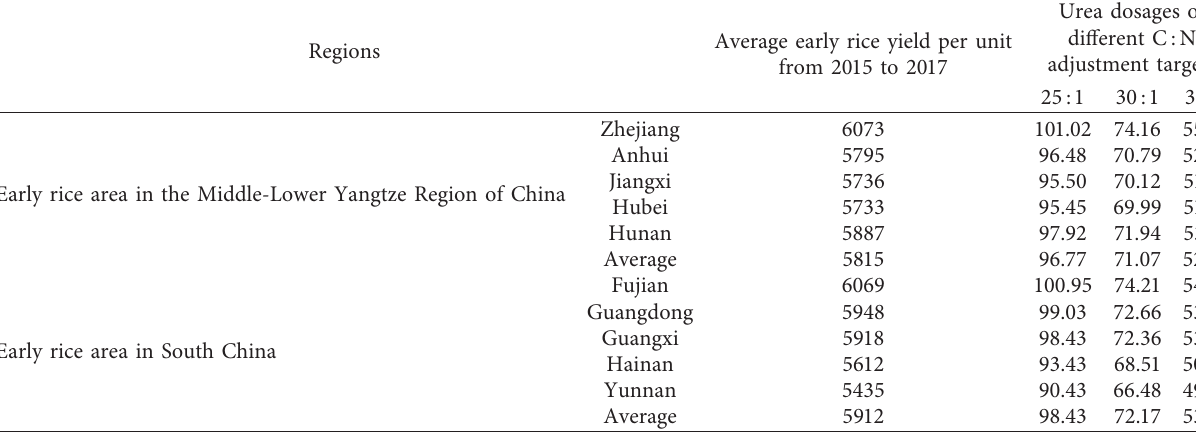
Table 7: Enquiry table for urea applied to early rice straw returning to the field in two major early rice areas and every provinces (cities, autonomous regions) in China.